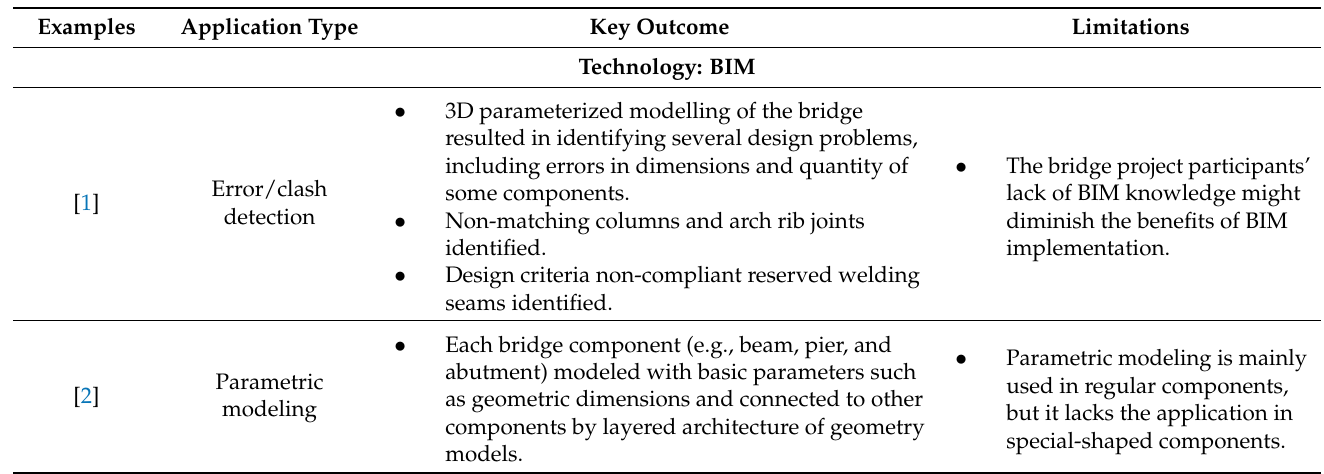
Table 3. BIM/GIS uses in planning and